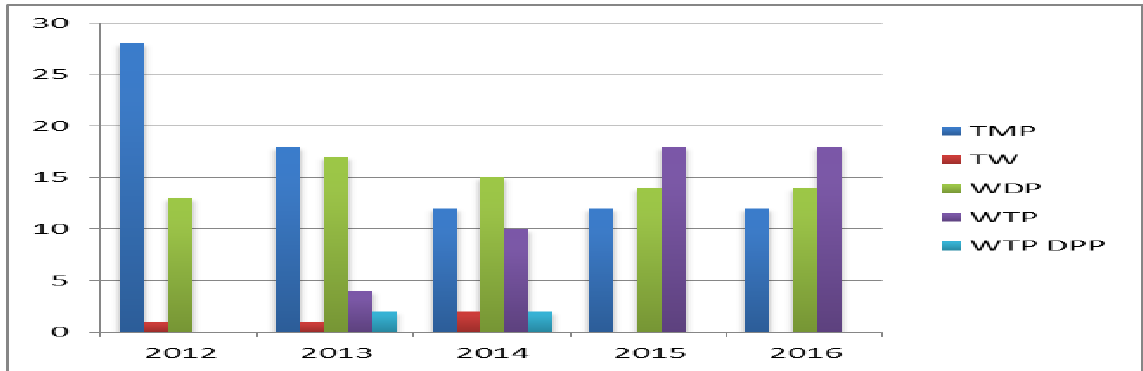
Figure 1.1 LKPD Opinion for 2012-2016 in Papua and West Papua Provinces